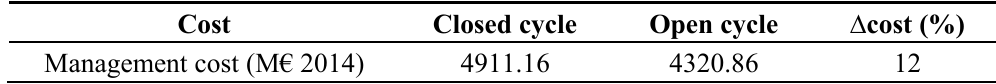
Table 6. Management cost for each fuel cycle